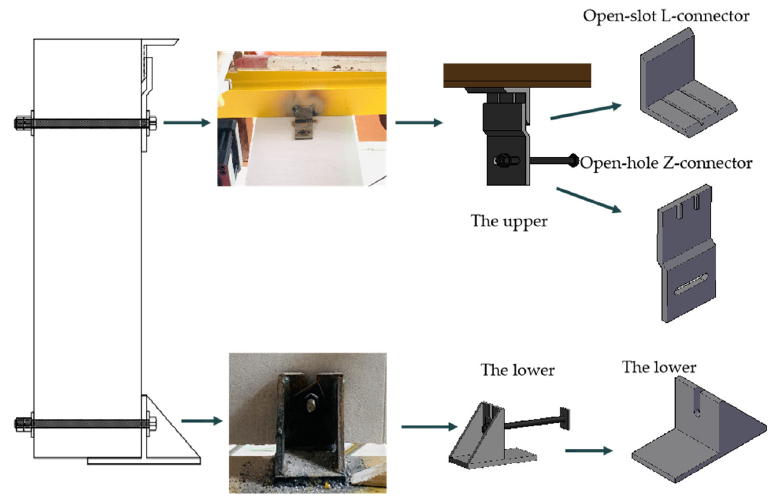
Figure 2. Connector installation diagram.